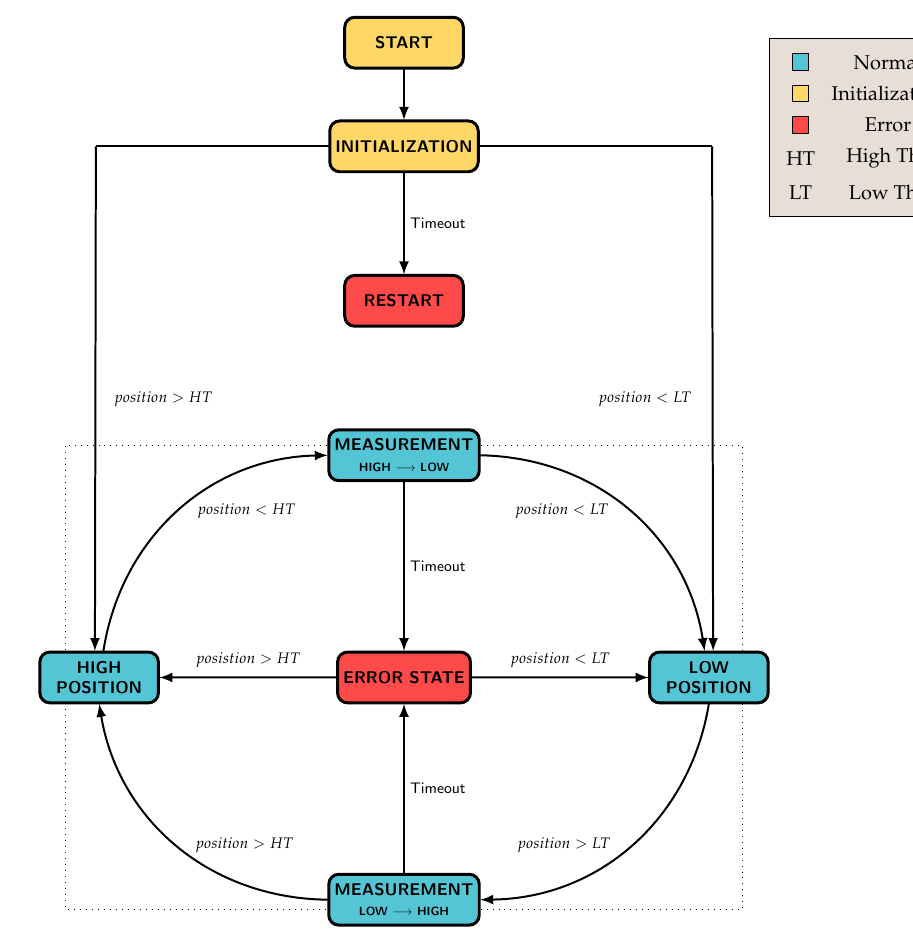
Figure 10. States and state-transitions of the